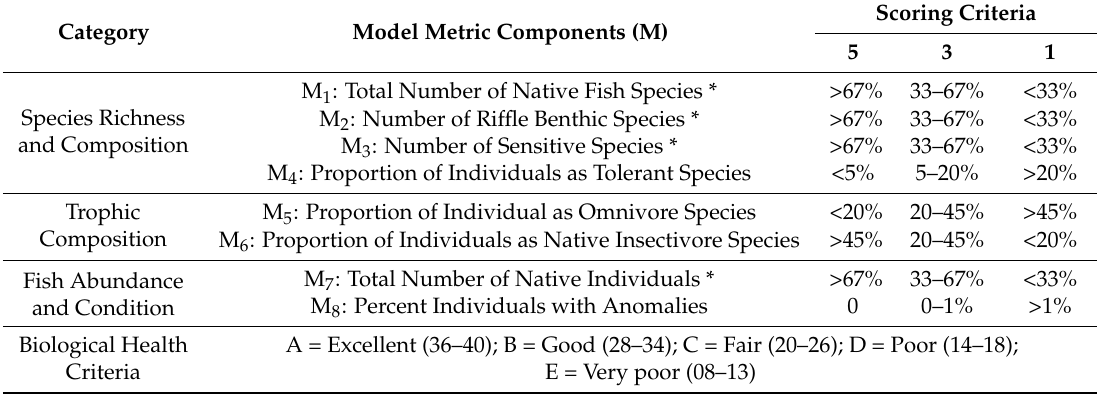
Table 1. Fish assemblages types, metrics and their ascribed scoring criteria in 08 metrics IBI model (mmIBI 08 ).